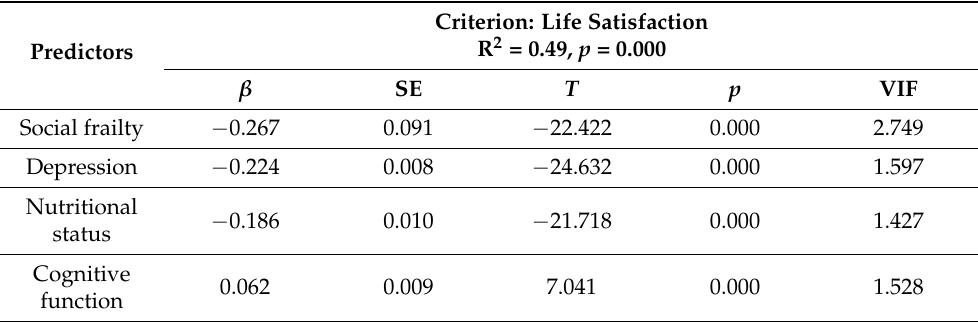
Table 4. Factors related to the life satisfaction of older adults.